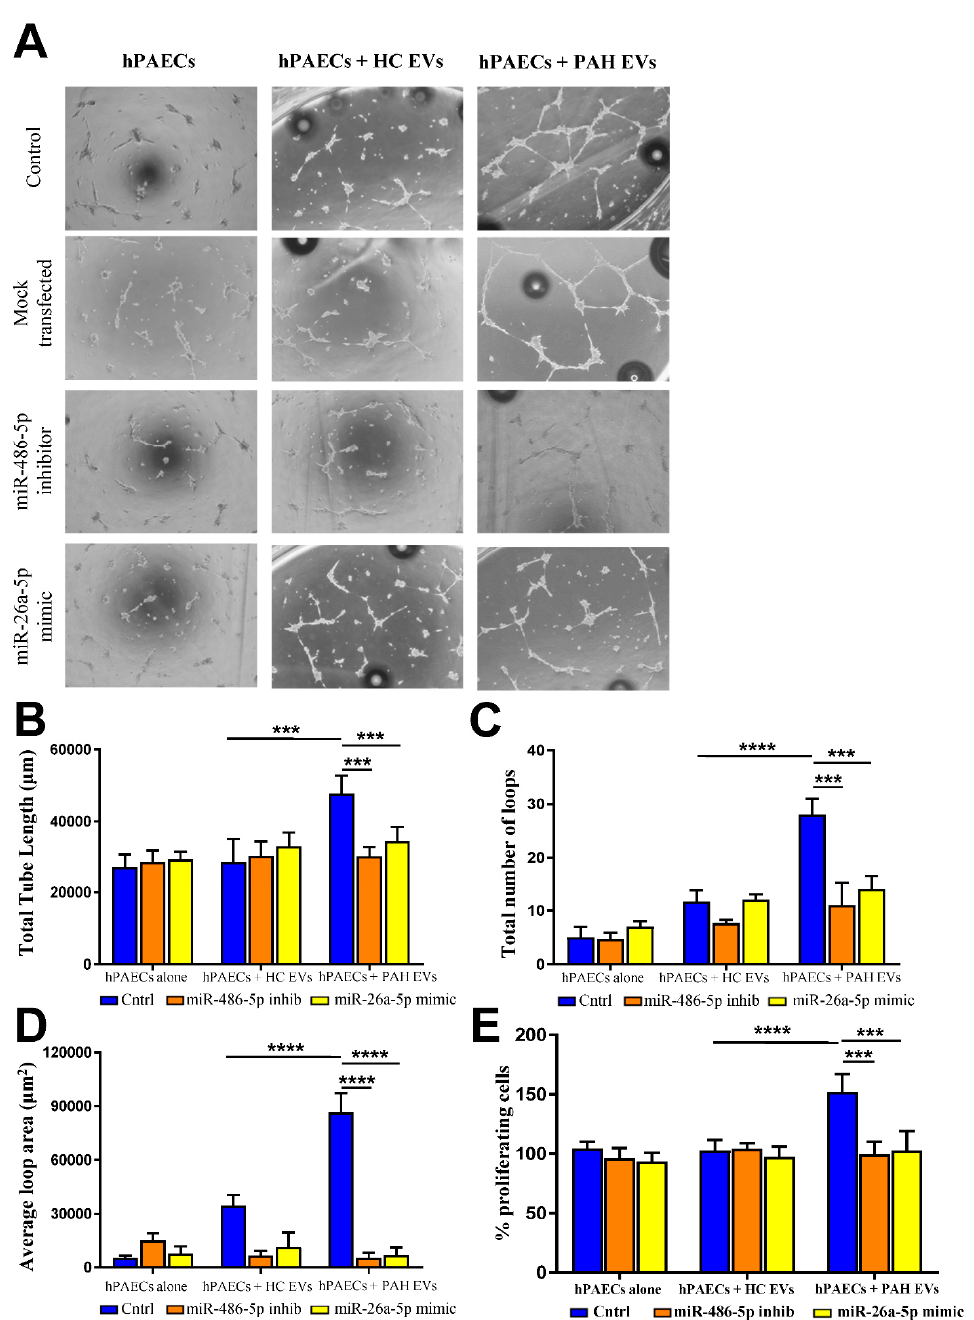
Figure 4. ( A ) Representative photomicrographs of an in vitro Matrigel angiogenesis assay, showing tube-like structure formation by hPAECs, either untreated or incubated with EVs followed by miR inhibitor or mimic transfection. Images were taken at 4 × magnification. ( B ) The quantitative analysis of the length of branches. ( C ) Total number of loops. ( D ) Percentage of vessel loop area of in vitro- formed vessel-like structures. Results are from n = 3 biological replicates and indicated as mean value with SD. ( E ) Relative cell proliferation of hPAECs presented as % of untreated cells when incubated with PAH or HC EVs for 1 h followed by transfection of miR inhibitor or mimic for an additional 48 h. ( n = 5 per group in triplicates). Data are presented as mean with SD. All the data were analyzed by two-way ANOVA. *** p < 0.005 and **** p <